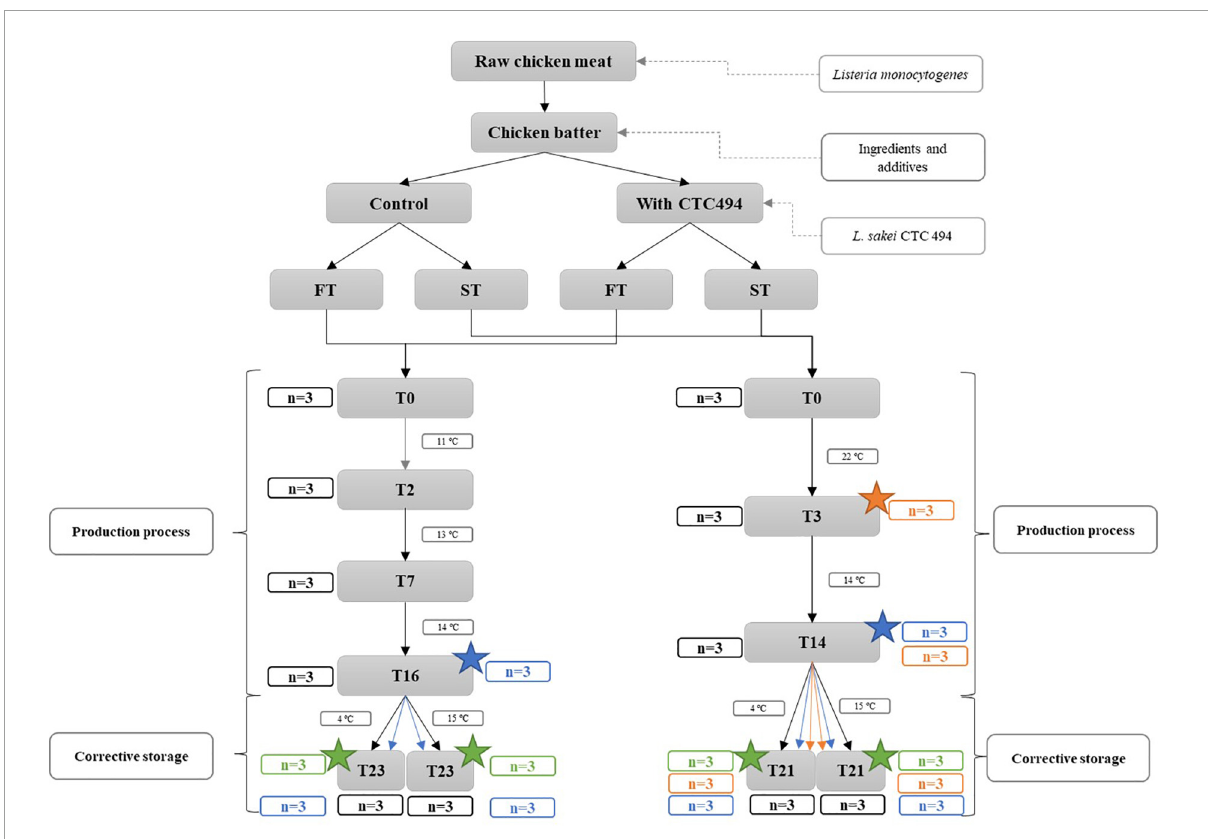
FIGURE1 Summary of the manufacturing process and sampling scheme of fuet -type (FT) and snack-type (ST) fermented sausages ( n is the number of sampled sausages at each point). Application of high-pressure processing (HPP) is indicated with a